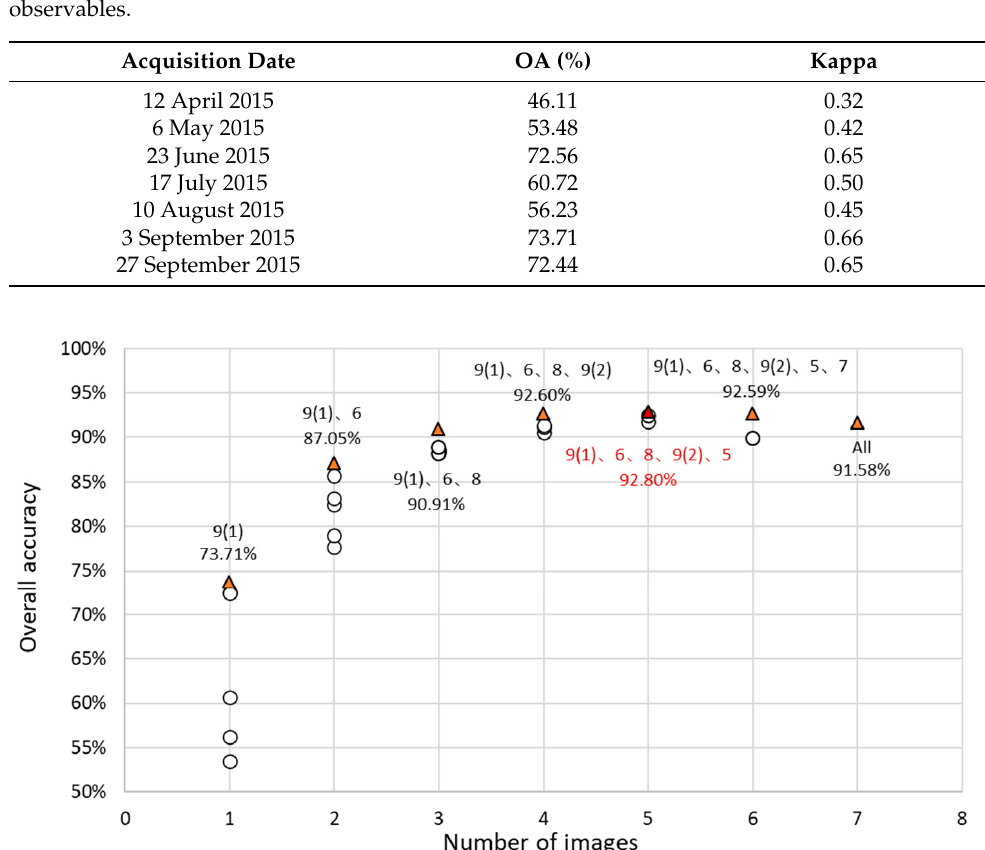
Figure 12. The RF overall accuracies for the optimal combination SAR image produced by a forward image selection procedure using all polarimetric observables. Note that numbers in the figure denote the best accuracy in each step (at the bottom), and combinations of SAR images (at the top), for example “9(1), 6, 8, 9(2)” represents the combination of images dated 3 September, 23 June, 10 August and 27 September (see Table 1).